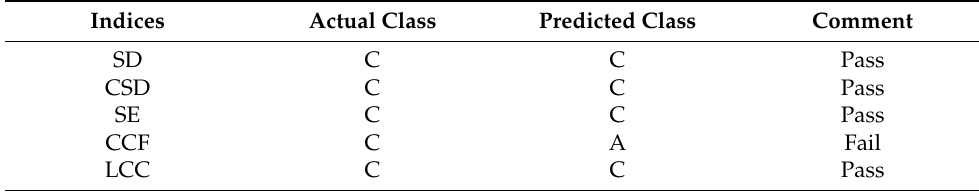
Figure 26. Frequency response of U-phase HV winding before and after the fault ( left ) and axial displacement of U-phase HV winding ( right ) [25]. Table 4. Performance metrics of ANN for different indicators in assessing case 3.